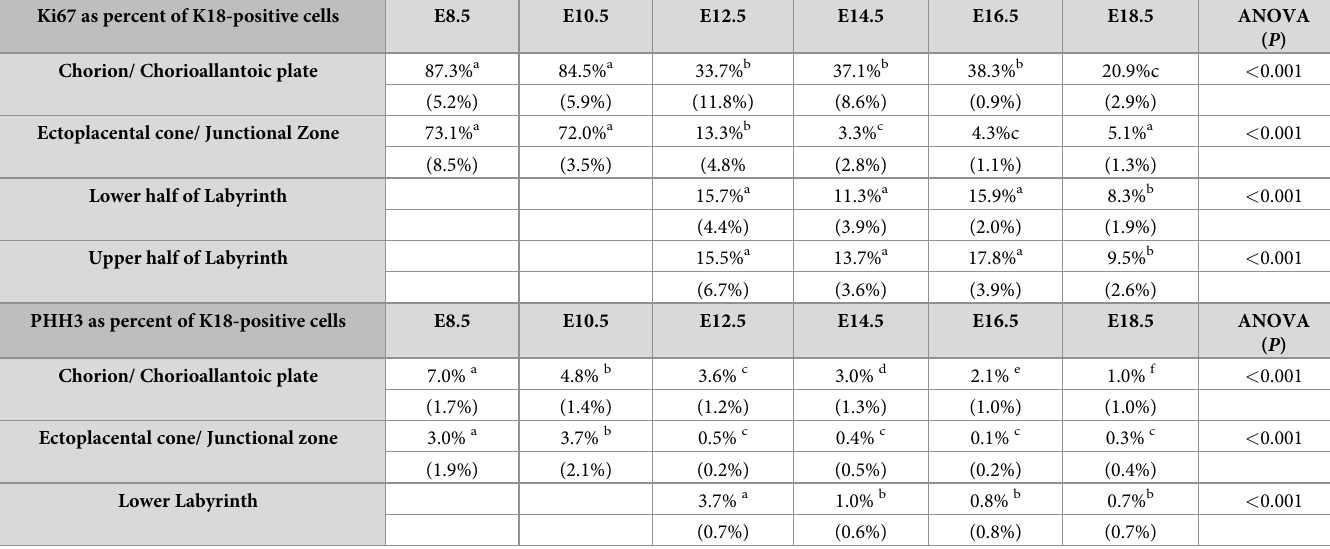
Table 1. Percentage of trophoblast cells undergoing the cell cycle between E8.5 and 18.5. Data represent mean and SEM is in